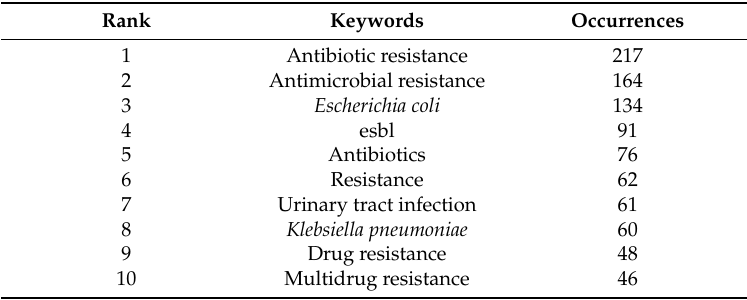
Table 2. Top 10 author keywords of CA and antibiotic resistance studies. Rank Keywords